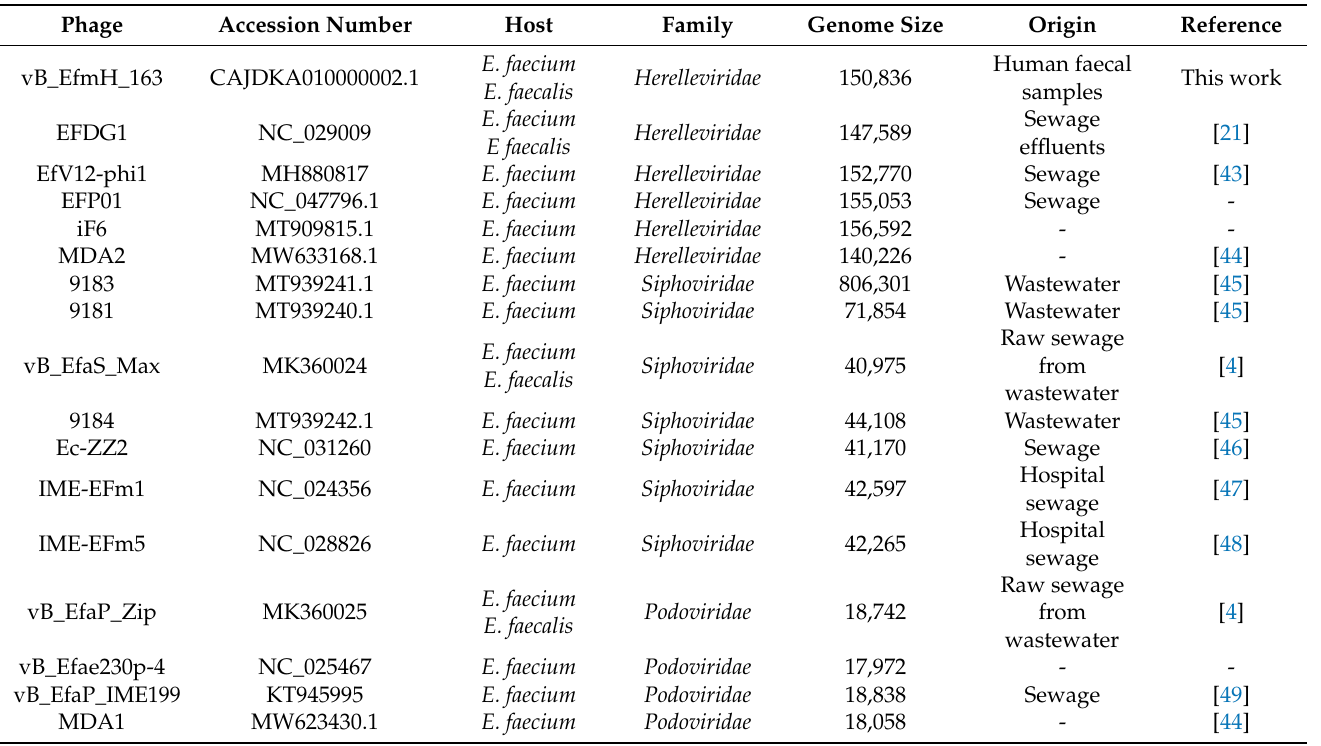
Table 2. Characteristics of the E. faecium phages used in the phylogenetic analysis. Genome size and accession number are